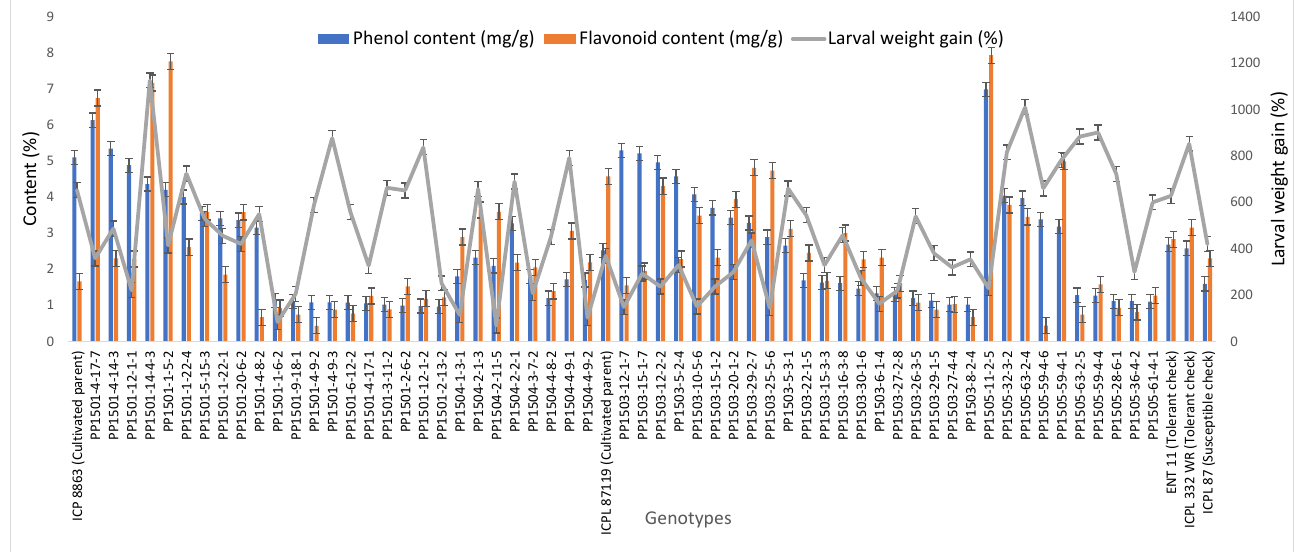
Figure 3. Total phenols and flavonoids concentrations in seeds and larval weight gain in selected ILs, and their cultivated recurrent parents and checks. Evaluations were conducted during the 2019 rainy season at ICRISAT, Patancheru, India. Error bars indicate standard error of the mean. The total flavonoids concentration in the seeds ranged from 0.44 to 12.01 mg/g (Figure 3). The highest flavonoids concentration was recorded in PP1503-28-1-3 (12.01 mg/g), followed by PP1503-6-2-5 (10.25 mg/g), PP1503-22-3-1 (10.12 mg/g), PP1505-11-2-5 (7.93 mg/g), PP1501-1-5-2 (7.77 mg/g), PP1501-14-2-1 (7.44 mg/g), PP1501-14-4-3 (7.16 mg/g), PP1501-4-17-7 (6.75 mg/g), and PP1505-11-2-4 (6.07 mg/g) ( p ≤ 0.001). These values were higher than those in the cultivated recurrent parents, ICP 8863 (1.67 mg/g) and ICPL 87119 (4.58 mg/g), and the checks ENT 11 (2.84 mg/g), ICPL 332WR (3.16 mg/g), and ICPL 87 (2.31 mg/g) (Figure